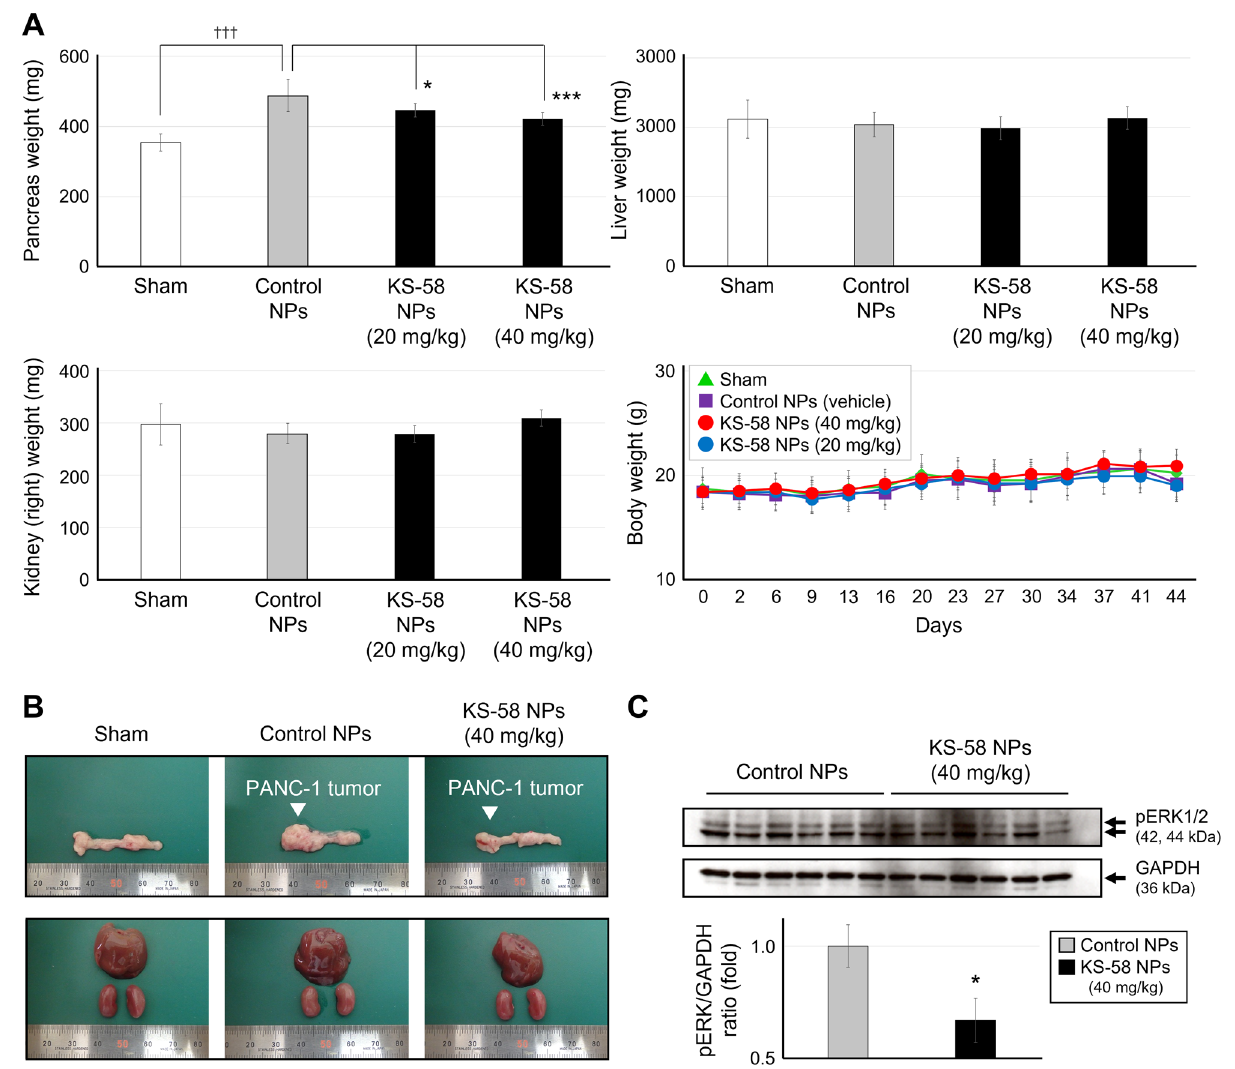
Figure 5. Antitumor efficacy of KS-58 NPs in mice bearing PANC-1 orthotropic xenografts. ( A ) Weight of pancreas, liver, and kidneys (right) collected from the mouse groups on day 44 (n = 8, * p < 0.05, *** p < 0.001 vs. Control NPs group by Dunnett’s test, ††† p < 0.001 vs. the Sham group by a Student’s t-test) and changes in body weight (n = 8 mice per group, expressed as mean ± SD). ( B ) Representative appearance of each organ (left: pancreas, right: liver and kidneys) from mice in the orthotopic xenografts experiments. ( C ) PANC-1 tumors collected from control NPs group and KS-58 NPs group were homogenized and phosphorylated ERK (pERK) and GAPDH were quantified by Western blotting. Expression levels of pERK were normalized by GAPDH and presented as the fold change relative to the control NPs group (n = 6 tumors per group, ± SEM, * p < 0.05 by a Student’s t-test).